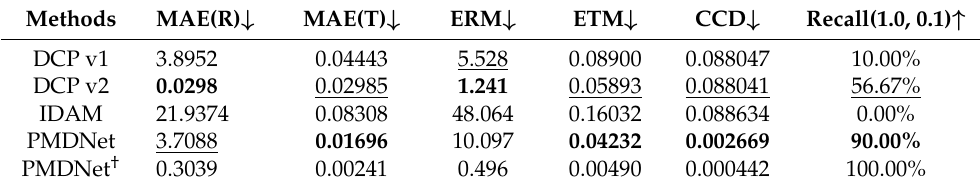
Figure 8. Qualitative results of the PMDNet on density-uniform clean BIM data. src , ref , and pred clouds are colored in green, red, and blue, respectively. Table 9. Results on noise density-uniform BIM scenarios. Bold and underline denote best and second best performance, respectively. PMDNet fails on three scenarios, contributing to large MAE ( R ) and ERM , but achieves great performance on all the other samples. PMDNet † shows the metrics on successfully predicted scenarios.